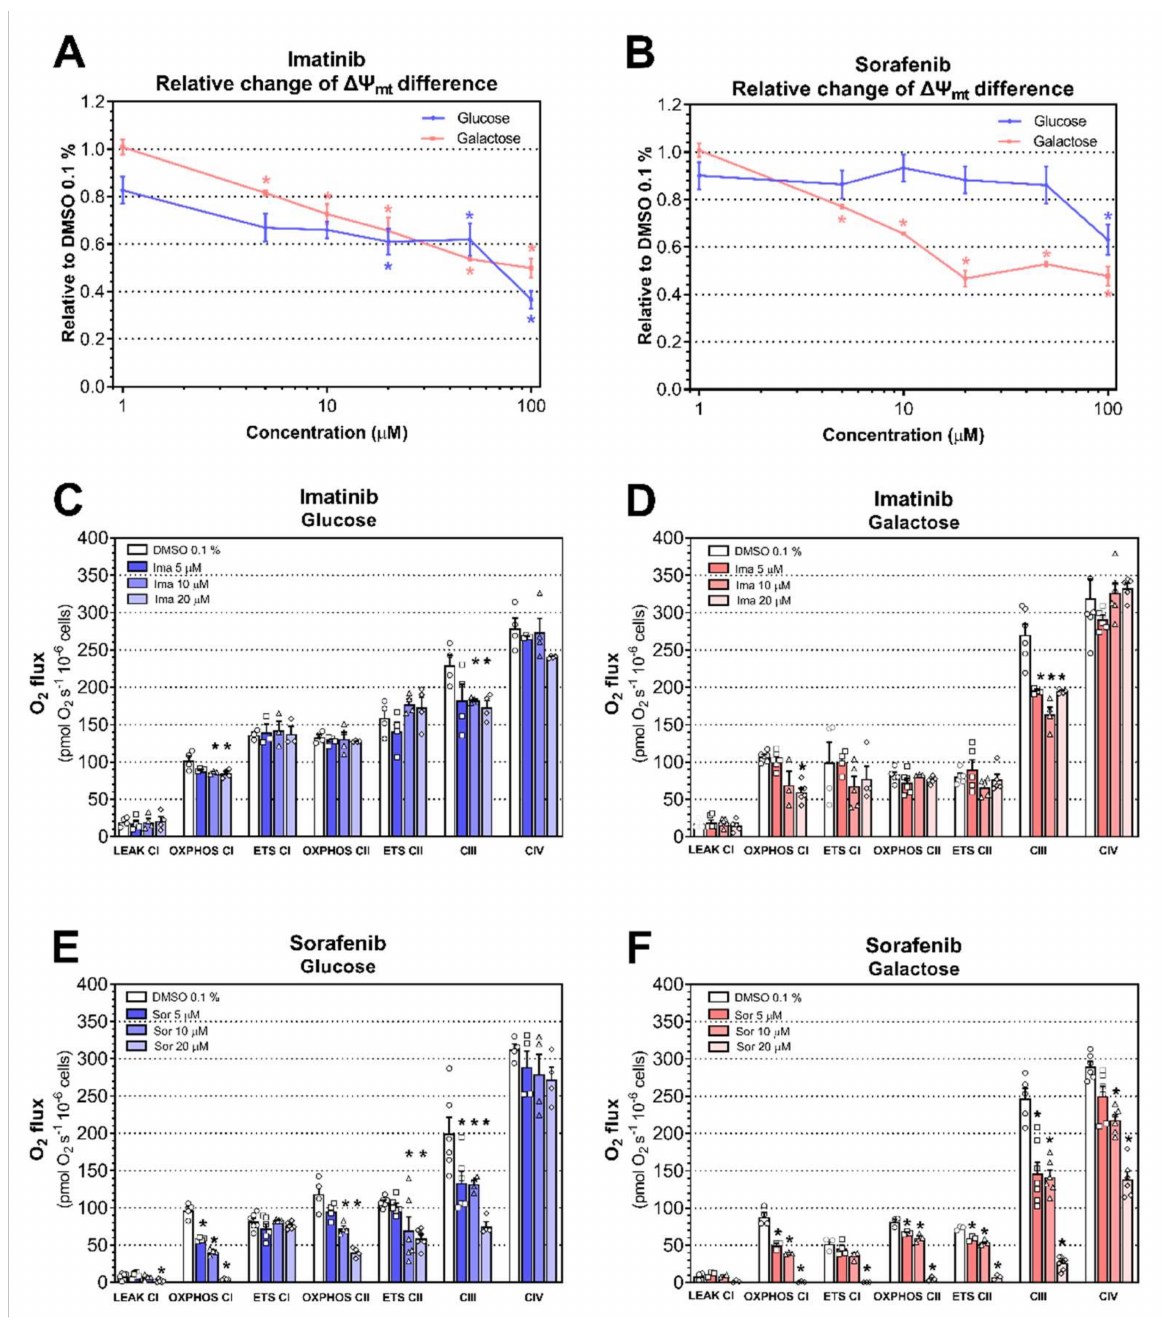
Figure 2. Effects of imatinib and sorafenib on TMRE fluorescence intensity for mitochondrial mem- brane potential and on mitochondrial respiratory capacities. ( A , B ) Relative change of mitochondrial membrane potential difference in H9c2 cells exposed to imatinib ( A ) and to sorafenib ( B ) under glucose and galactose media. ( C , D ) Respiratory capacities through complexes of the ETS in H9c2 cells exposed to imatinib for 24 h under glucose ( C ) and galactose ( D ) media. ( E , F ) Respiratory capacities through complexes of the ETS in H9c2 cells exposed to sorafenib for 24 h under glucose ( E ) and galactose ( F ) media. Data represent the mean ± SEM of at least four independent experiments. * P < 0.05 versus 0.1% DMSO